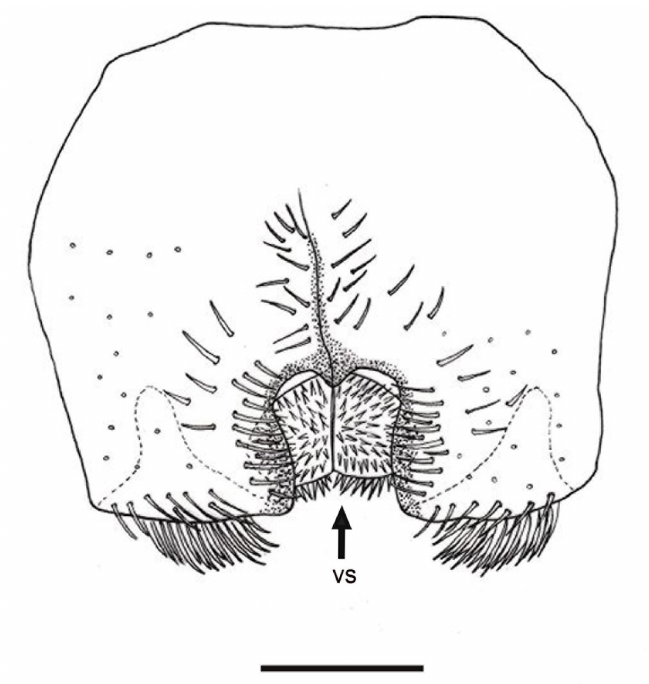
Fig. 6. Eumerus colladoi Ricarte & Aguado-Aranda sp. nov., paratype, ♂ (CEUA-CIBIO), sternum IV. Abbreviation: vs = valves. Scale bar: 250